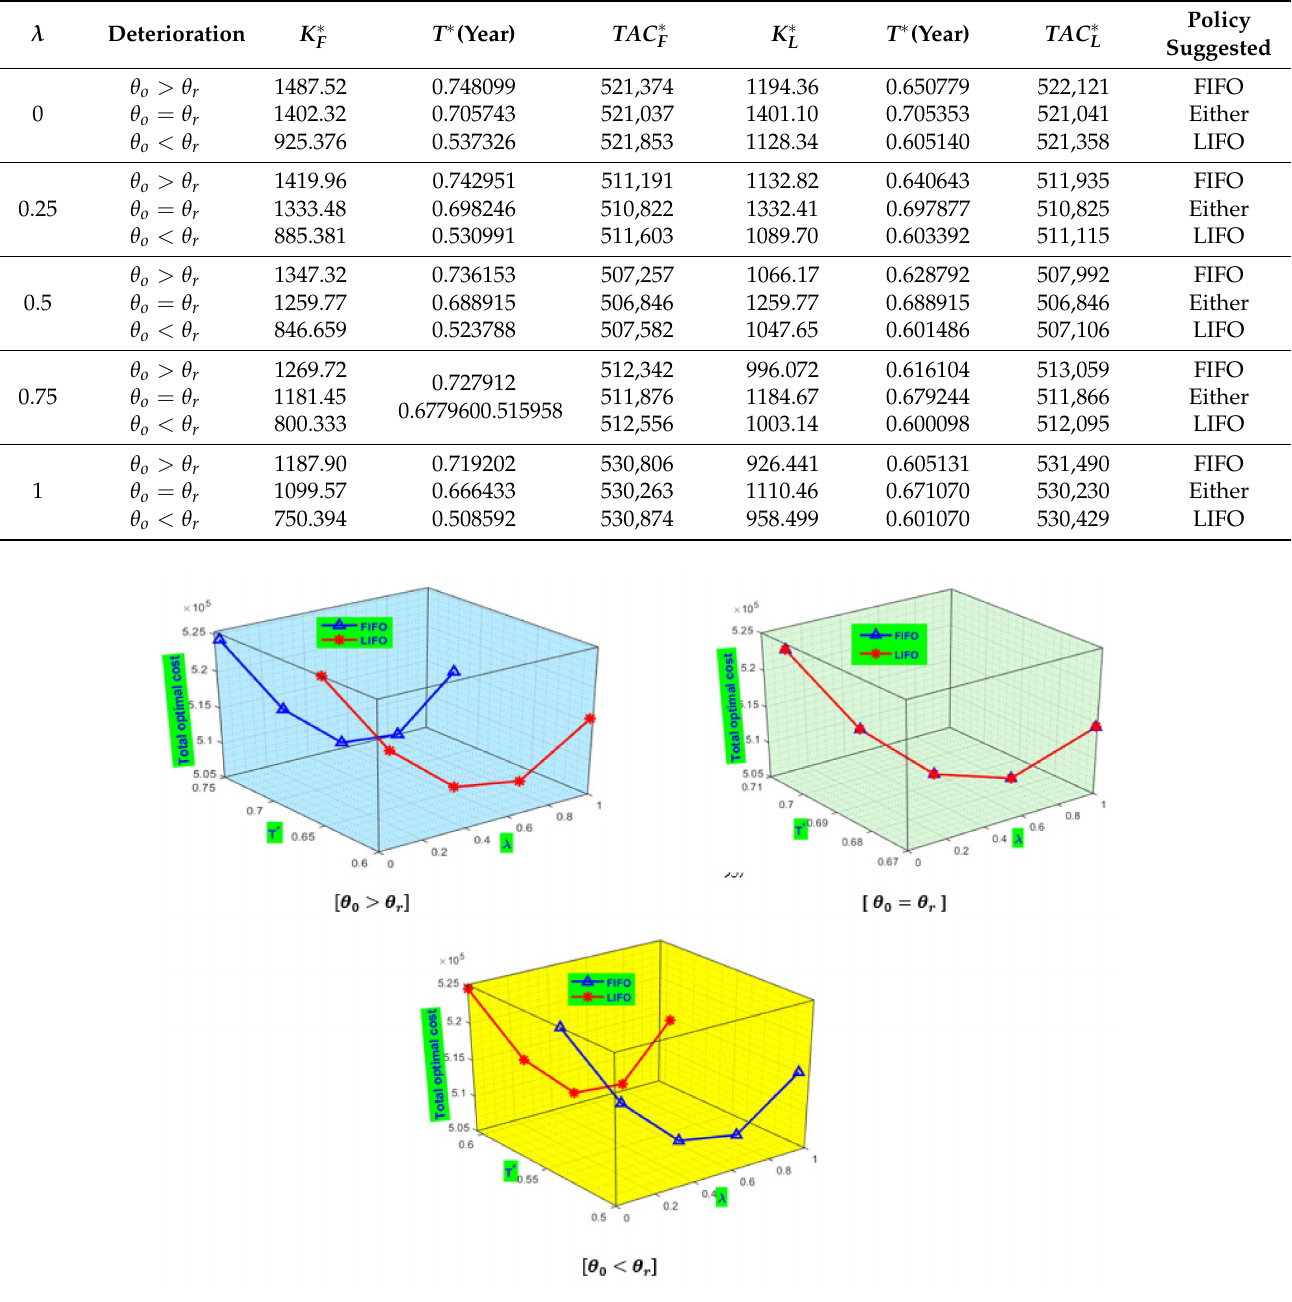
Figure 8. Graphical representation of total cost under various values of λ